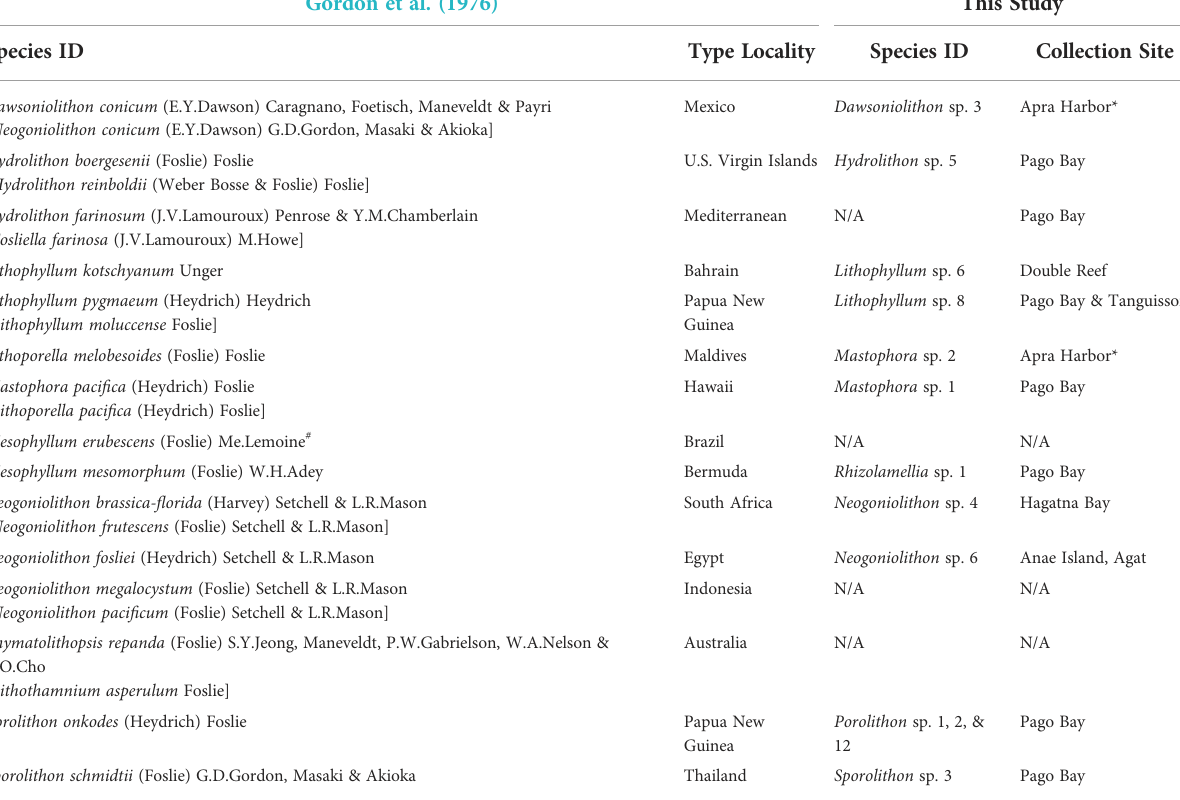
TABLE 1 Currently accepted names of CCRA species (Guiry and Guiry, 2022) reported for Guam by Gordon et al.